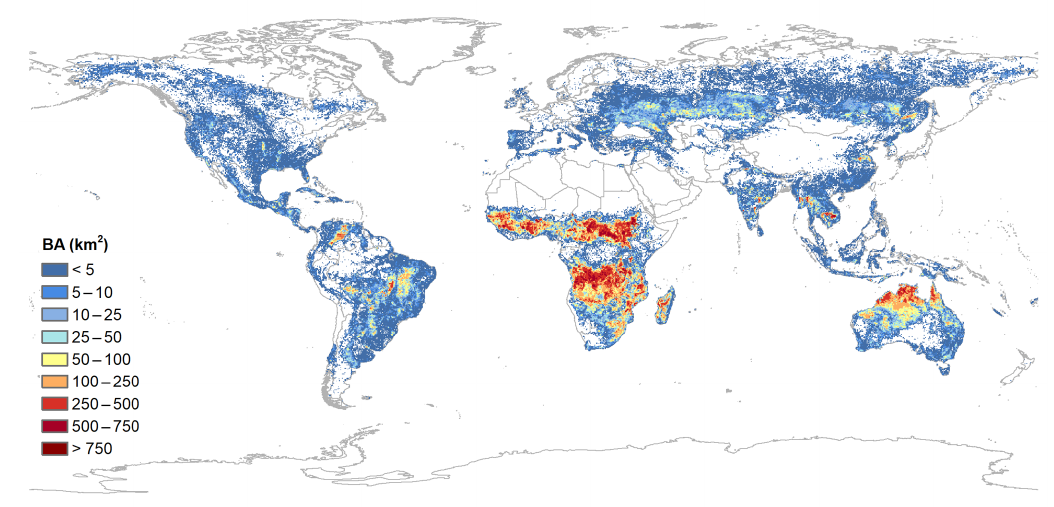
Figure 1. Average global annual BA from the FireCCI50